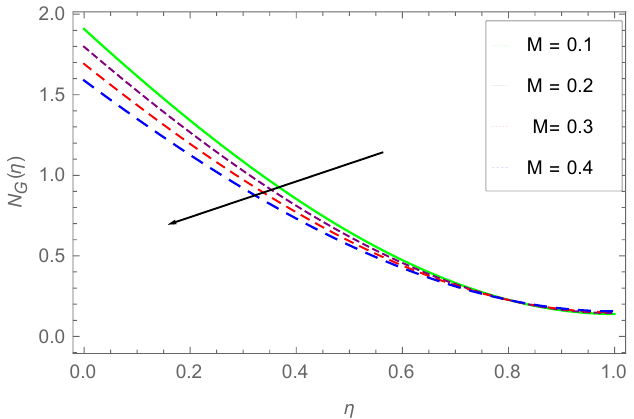
Figure 22. Variations in the function of entropy N G ( η ) for unlike values of M , when Br = 0.3, R e = 0.7, Rd = 0.7 and Pr =